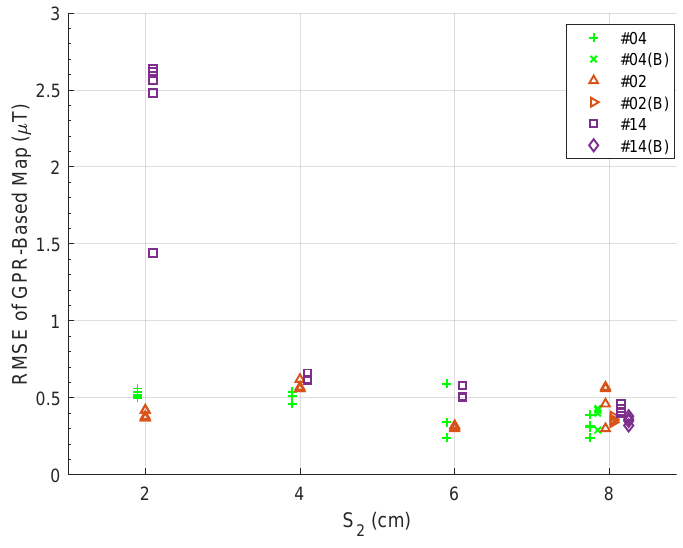
Figure 10. S 2 versus vector GPR RMSE. At each S 2 , the map is trained on one flight from battery #04 (green +). For S 2 = {2,4,6,8} cm there are N = {5,4,3,8} reps per